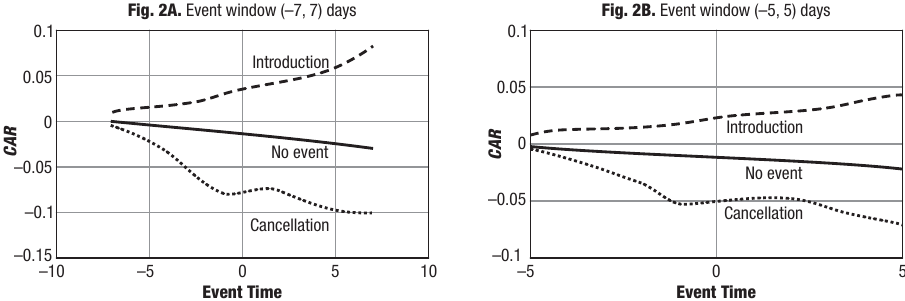
Fig . . 2A Event window ((cid:2) , ) days7 7 Fig . . 2B Event window ((cid:2) , ) days5